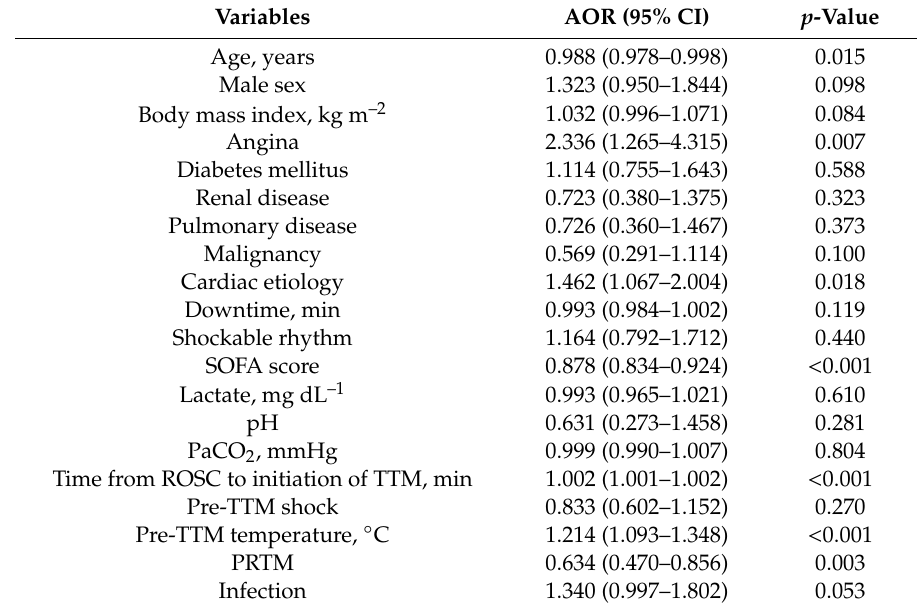
Table 3. Multivariate logistic regression analysis to assess independent risk factors for the development of post-rewarming